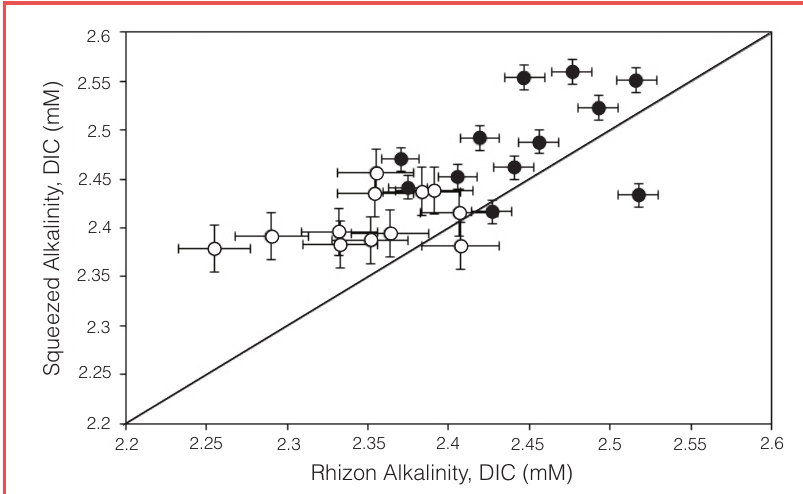
Figure 2. EQP-9 alkalinity (filled circles) and DIC (open circles) concentrations from Rhizon and squeezing methods. Line is 1:1. 0.5% and 1% error bars on alkalinity and DIC,